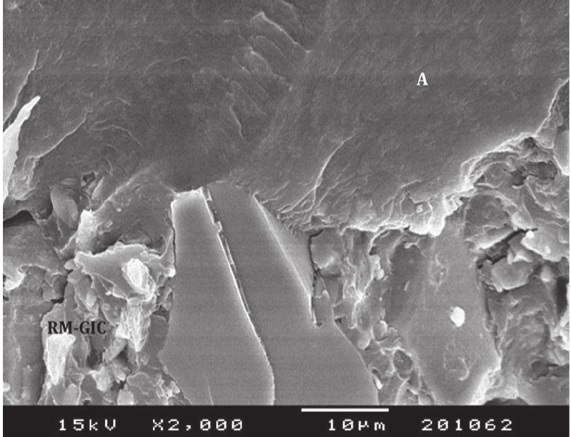
Figure 3- Good interlocking adhesion between resin- modified glass-ionomer cement (RM-GIC) and adhesive